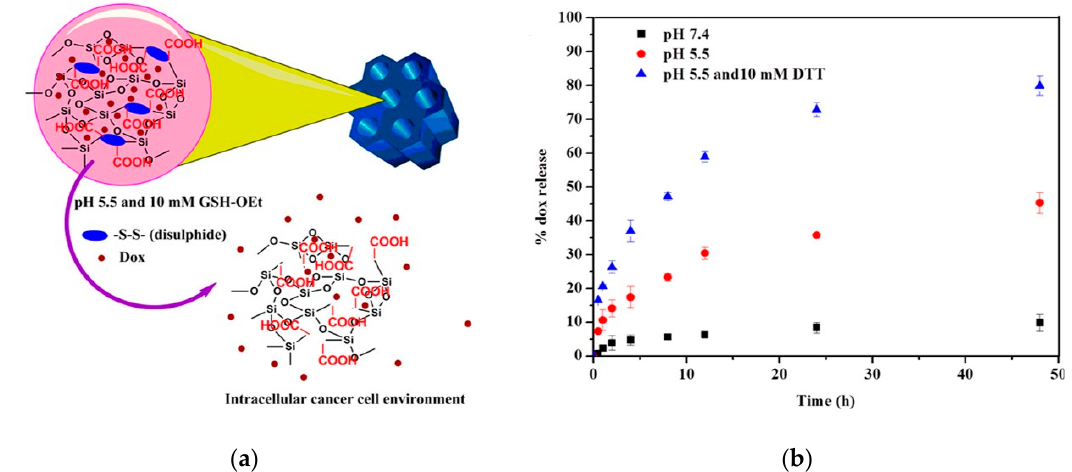
Figure 4. ( a ) Schematic representation of destabilization of cystamine-integrated periodic mesoporous organosilica (Cys-PMO) hybrid nanoparticles in response to redox and acidic pH environment and ( b ) in vitro DOX release profile from Cys-PMO hybrid nanoparticles. Reprinted with permission